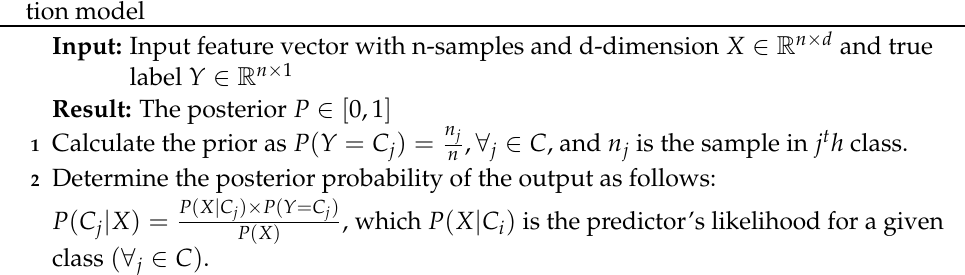
Algorithm 6: The procedure for applying the GNB and BNB diabetes detec- tion model